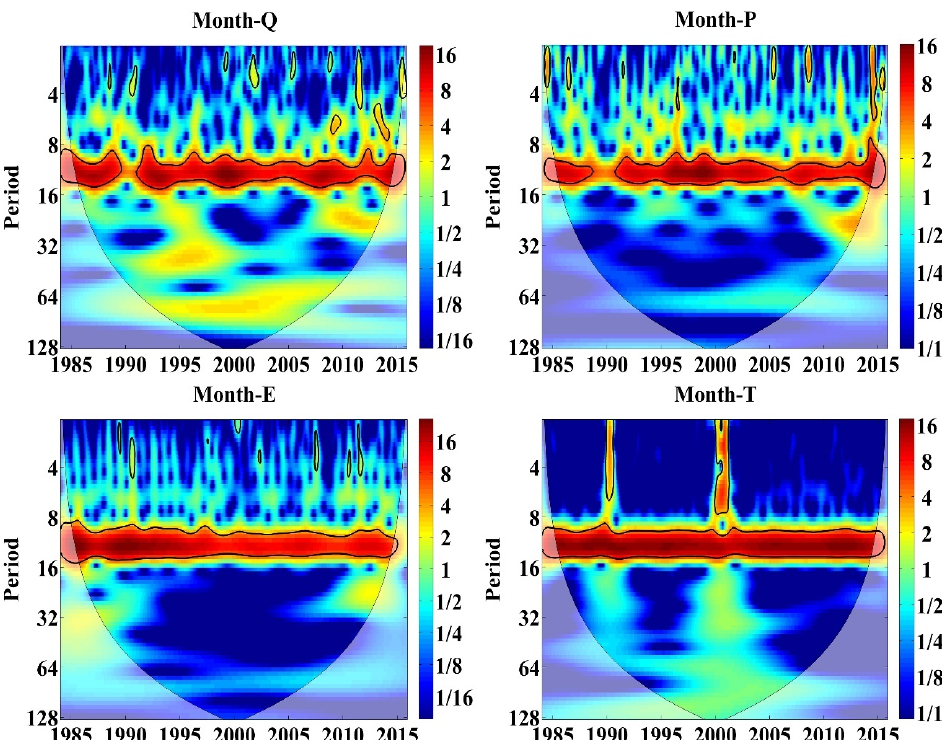
Figure 9. The continuous wavelet power spectra of monthly runoff (Month Q), rainfall (Month P), evaporation (Month E) and temperature (Month T) in the Yinjiang River watershed. The thick black contour designates the 5% significance level against red noise and the cone of influence (COI) where edge effects might distort the picture is shown as a lighter shade.